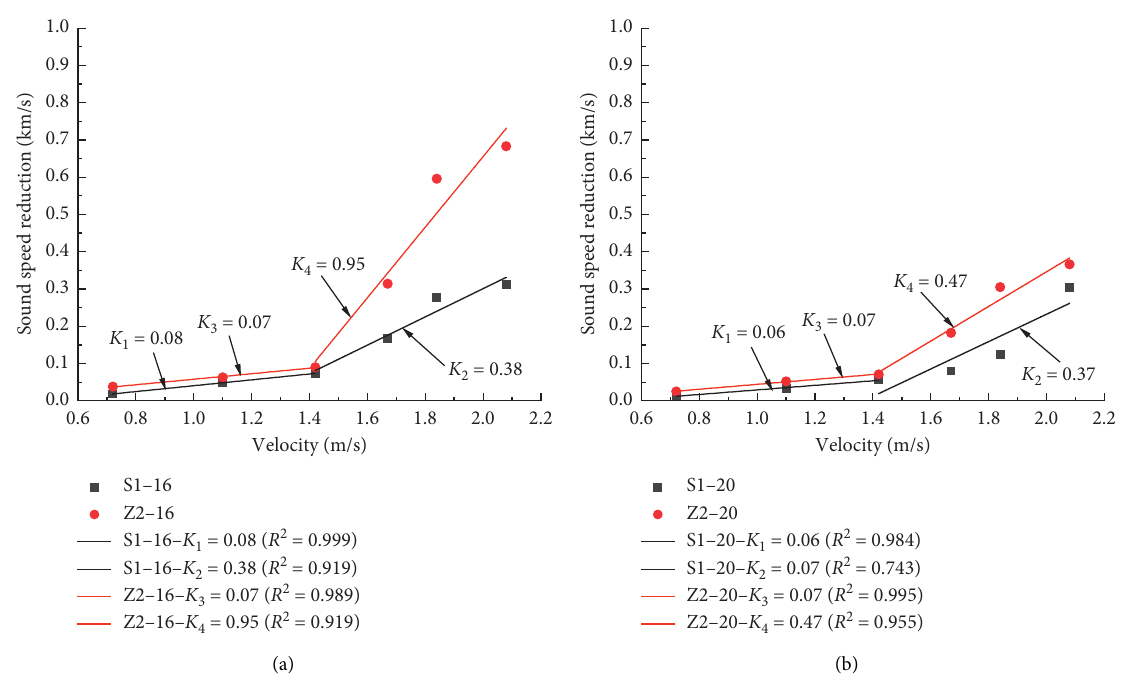
Figure 17: Correlation between the ultrasonic speed reductions and the impact speeds. In the figure, diameter 16 is 50mm closed-cell aluminum foam and diameter 20 is 100mm closed-cell aluminum